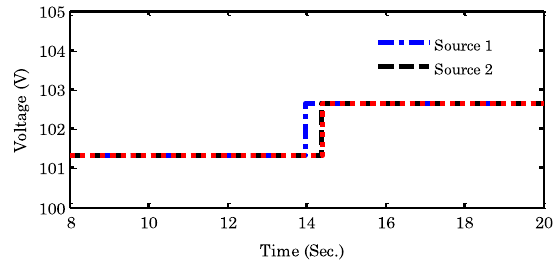
Fig. 8 Activation time of DERs and the updated reference voltage